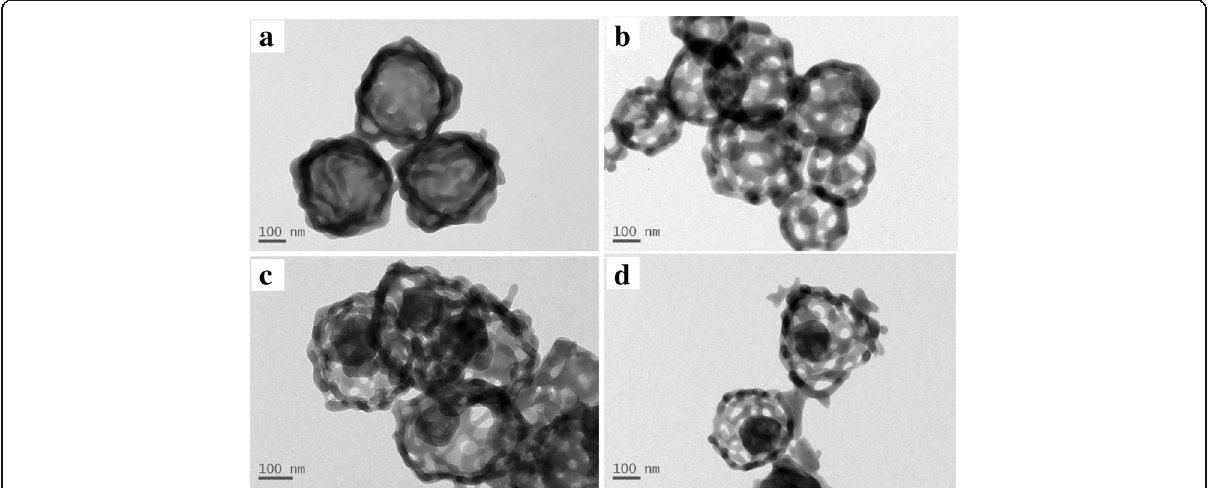
Fig. 3 TEM images of the products. a ACP-24-2. b ACP-48-2. c, d